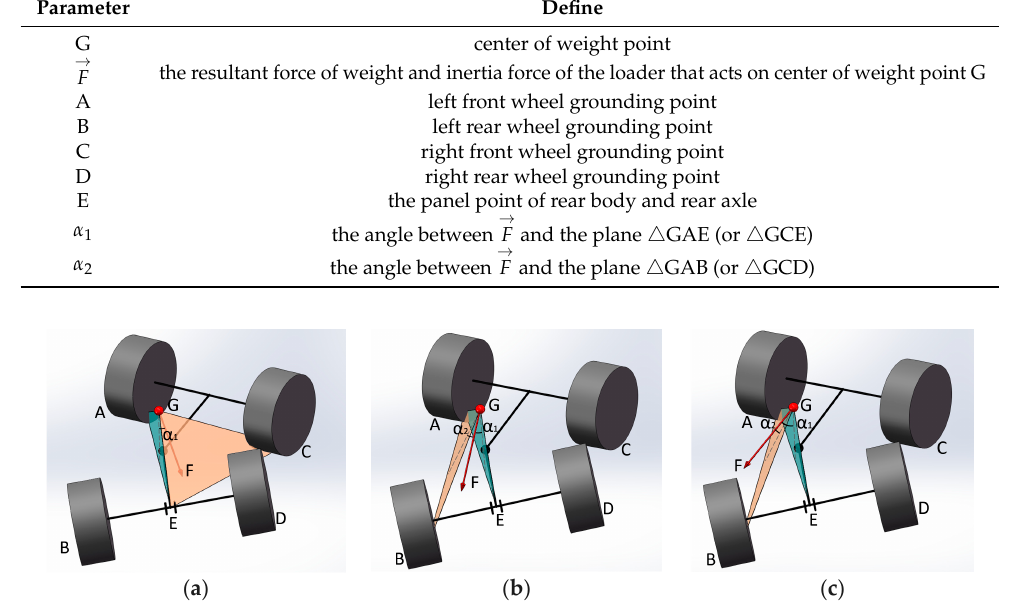
Figure 7. The relative location map of resultant force vector and stabilizing plane for an articulated wheel loader. ( a ) Steady state; ( b ) First stage unbalancing; ( c ) 2nd stage